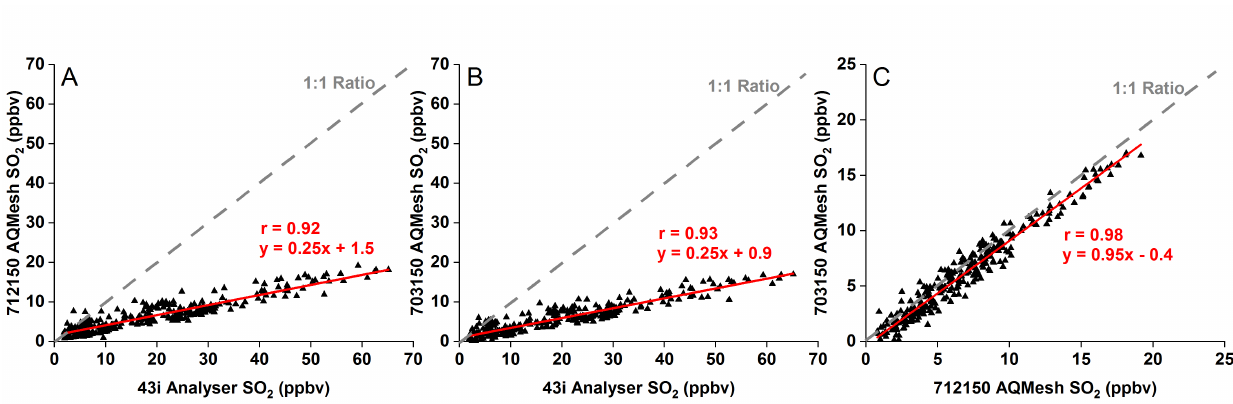
Figure 7: Co-location of 43i SO analyser and two AQMesh pods at El Crucero measurement station. Comparisons 2 of SO measurements between [A] 43i analyser and the SO electrochemical sensor in the 712150 AQMesh pod; 2 2 [B] 43i analyser and the SO electrochemical sensor in the 703150 AQMesh pod; [C] SO electrochemical sensor in 2 2 the 712150 AQMesh pod and the SO electrochemical sensor in the 703150 AQMesh pod. Comparisons and data 2 presented here are the peaks in data, near-baseline measurements were removed as they were within the baseline noise fluctuations of the AQMesh sensors. Measurements from the 43i analyser have been corrected to remove baseline drift and to account for 18 % underestimation as indicated by post-fieldtrip calibration. PM (i.e. correlation with r 2 > 0.5, see Section 2.5.1